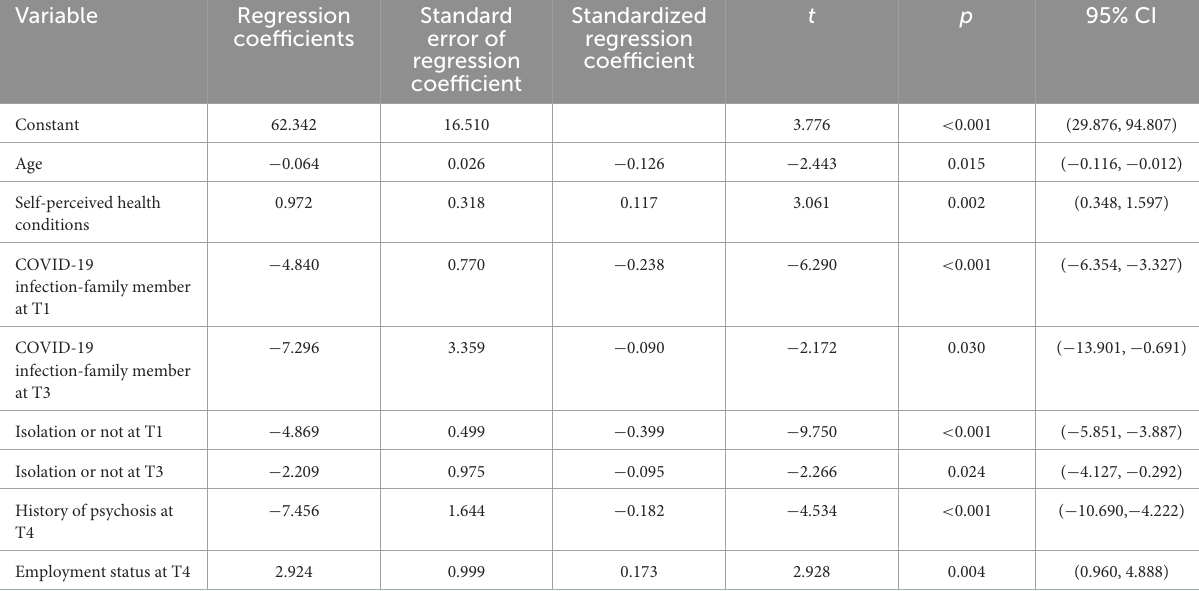
TABLE 6 Multiple linear regression analysis of influencing factors of